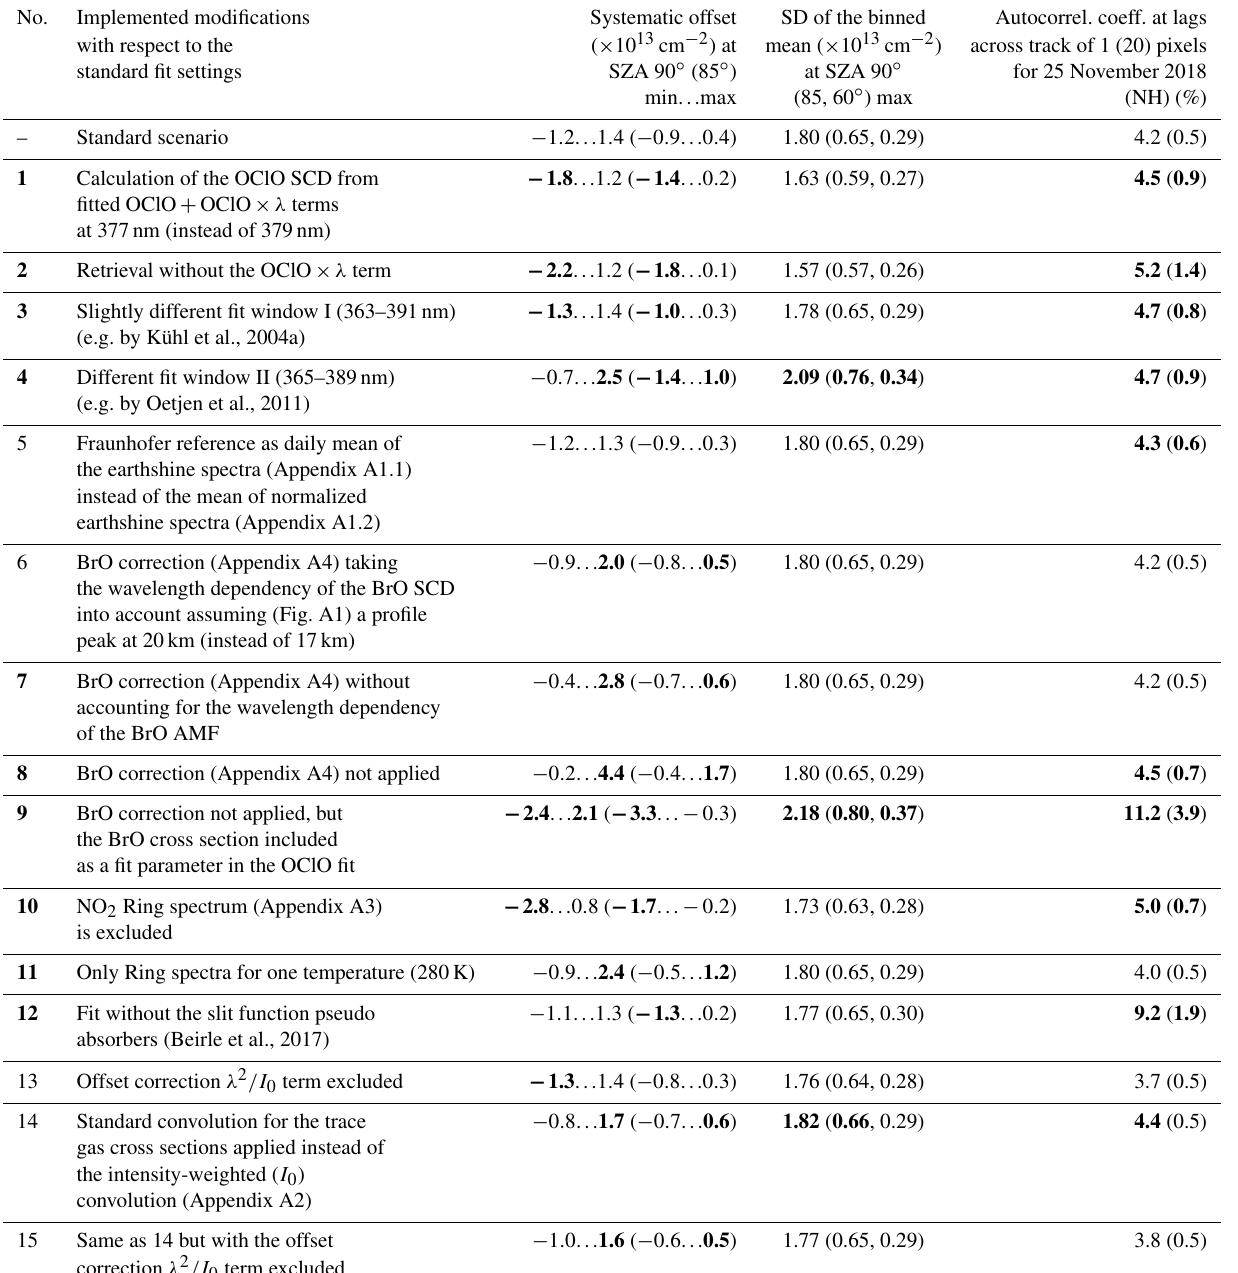
Table 2. Specific settings and results for the sensitivity studies; for details see Appendix B. Larger absolute values than for the standard case are marked in